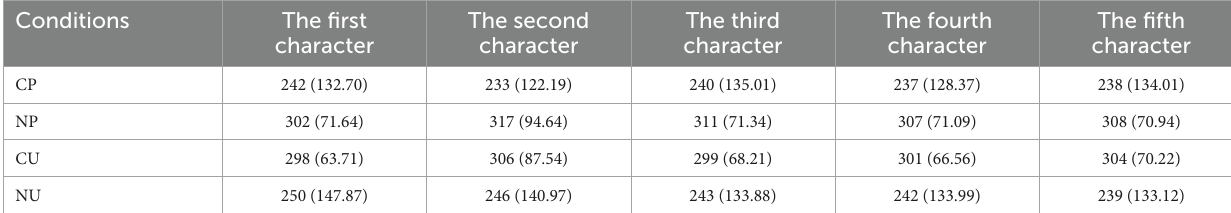
TABLE 2 The average reaction time (in milliseconds) and standard error of Chinese L1